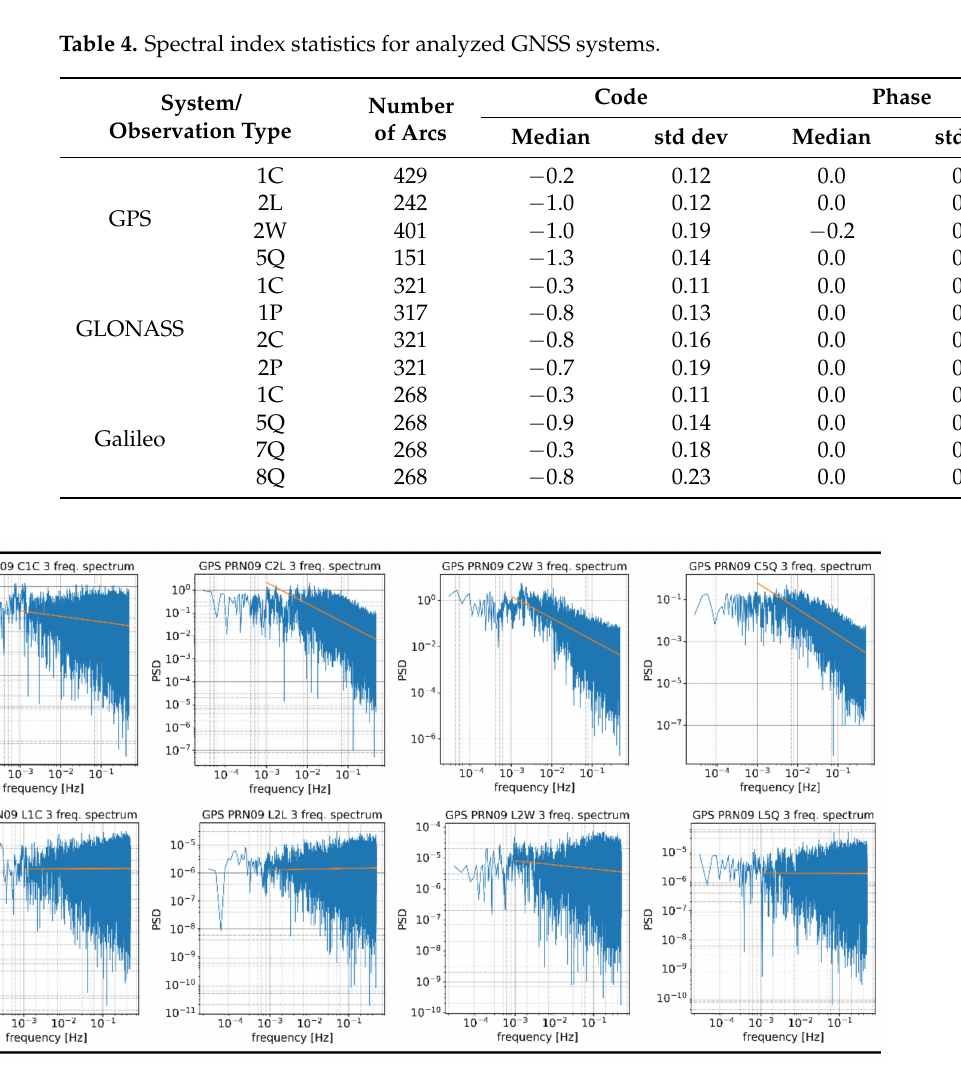
Figure 8. Lomb–Scargle periodograms for the GPS PRN09 satellite. Orange lines represent the line fitted in the part of the spectrum in the range of 0.001–0.5 Hz. The slope of the line represents the spectral index